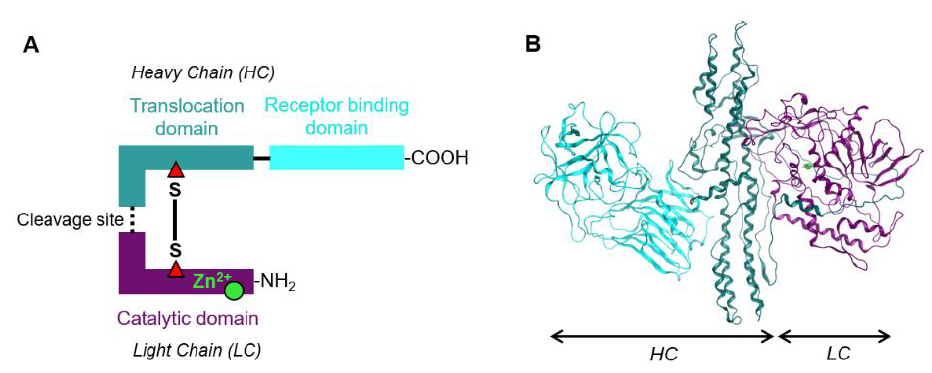
Figure 1. BoNT structure. ( A ) Schematic illustration of BoNT/A structure composed of the light chain (LC) peptide fragment (50 KDa) linked with a disulfide bond (S-S) to the heavy chain (HC) peptide fragment (100 KDa). The LC is a zinc (Zn 2+ ) endopeptidase responsible for catalytic activity, and the HC comprises a receptor binding domain responsible for neurospecific targeting and a translocation domain responsible for the LC translocation. ( B ) Illustration of BoNT/A crystalline structure. Same colors represent same elements in both parts of the figure. Neutralizing antibodies can distinguish at least seven different serotypes of BoNT, from A to G, that are structurally similar but antigenically distinct. Several studies reported that monoclonal antibodies can neutralize only some but not all serotypes suggesting variability within each neurotoxin serotype. Such variabilities are now revealed and ex- plained through sequencing of neurotoxin-encoding genes of bacteria infecting patient [32]. A BoNT protein that was tentatively named BoNT/H has been recently identified and corresponds to a chimeric toxin, with its LC similar to the LC of BoNT/F and its HC similar to the HC of BoNT/A. Furthermore, another apparently new BoNT serotype named BoNT/X, was recently identified [33,34]. BoNT/X has the lowest sequence identity with others serotypes and is not recognized by antisera against known (A–G) serotypes. All serotypes differ in their toxicity, molecular site of action, efficiency in terms of muscle paralysis, duration of effects, and specific affinity for their targets [34–39]. Each serotype has, for example, distinct binding and/or affinity specificity for different SNARE proteins (Table